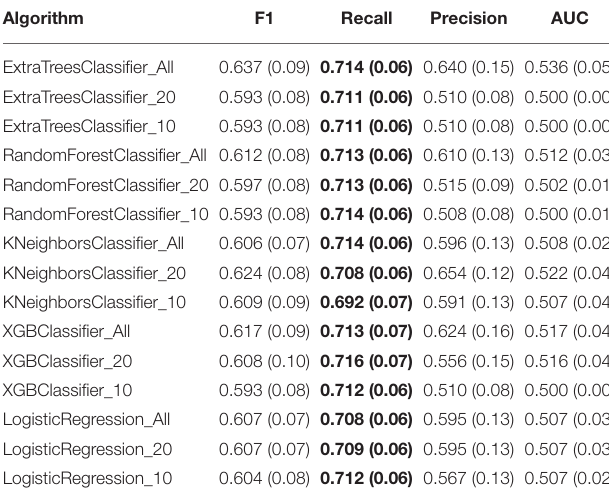
TABLE 7 | Evaluation of the pre-selected algorithms with hyper-parameters tuning. Algorithm F1 Recall Precision